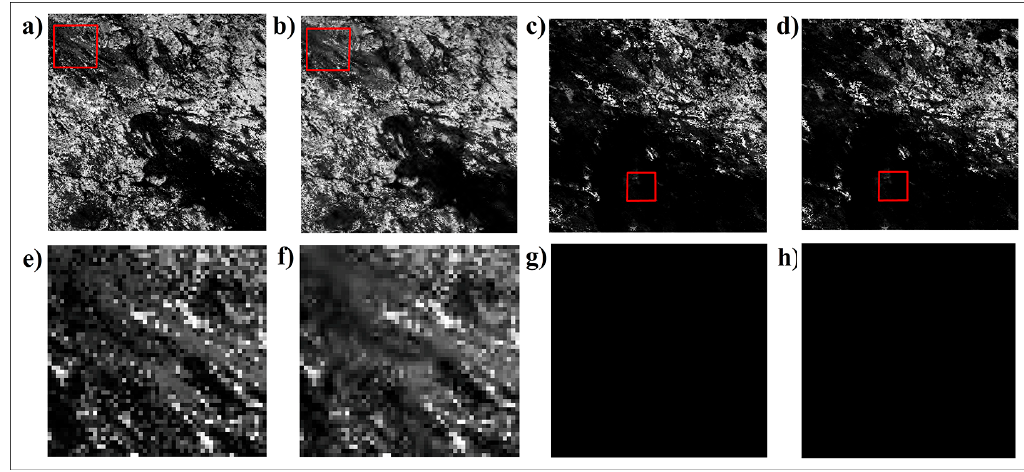
Figure 4. Comparison of original images and de-noised images including ( a ) the original image acquired from MOD17 on 1 January 2014, ( b ) the results of removing noise from the 1 January 2014 original image, ( c ) the original image acquired from MOD17 on 27 December 2015, ( d ) the results of removing noise from the 27 December 2015 original image, and ( e )–( h ) spatial subsets within the squares, delineated in red.